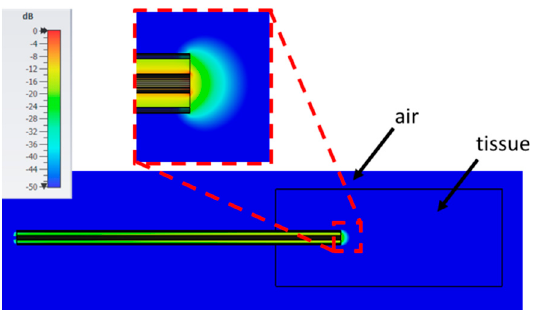
Figure 10. Percentage errors in the evaluation of the relative complex permittivity of fat at 25 °C through the reflection arrangement of the open probe technique. ( a ) real part; ( b ) imaginary part. The red curves give the error evaluated in the reference case, while the dashed blue line shows the error in the case where the maximum average error was calculated, i.e., case 10 in Table 2 (6; 5; 5; air).